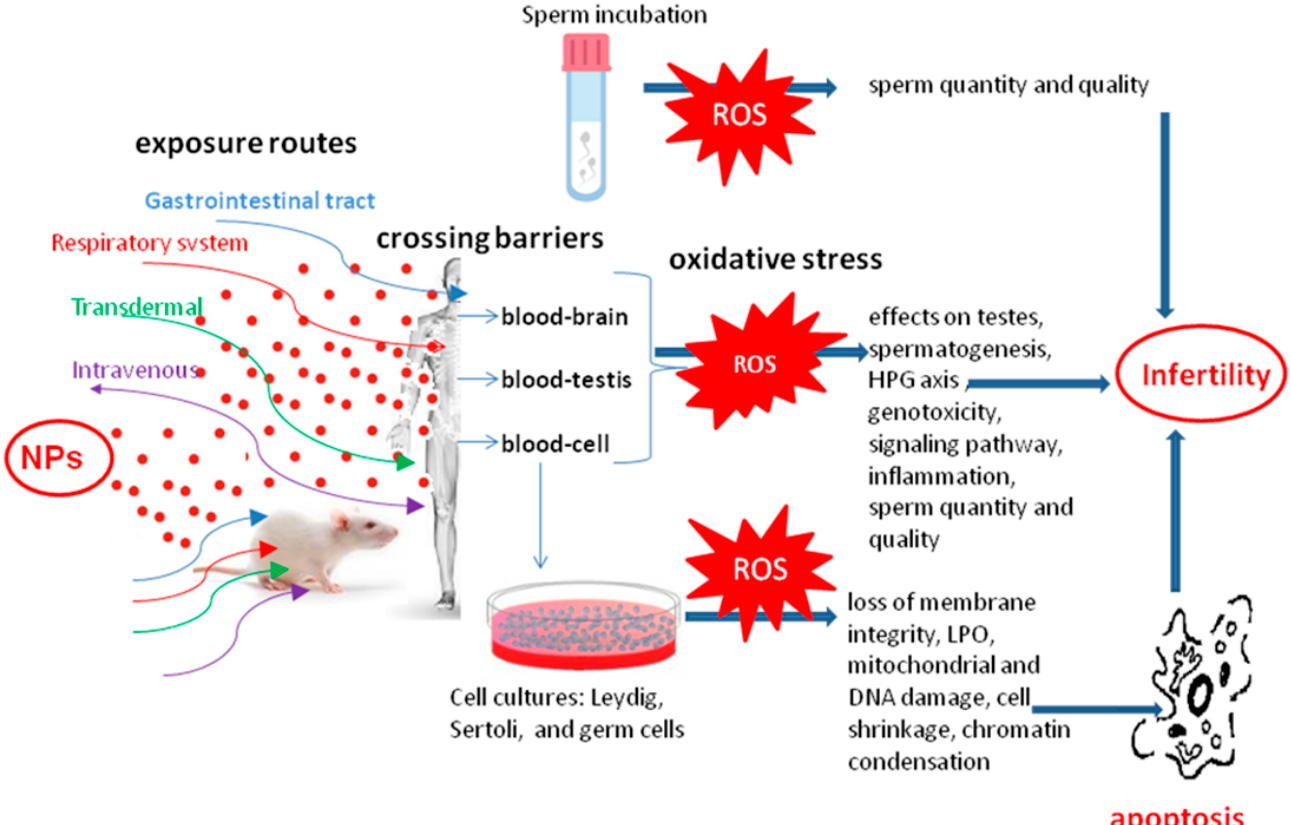
Figure 2. The effect of NPs on the fertility of in vivo and in vitro male models. Table 3. Influence of NPs on the male reproduction system. Based on Refs. [228–230].